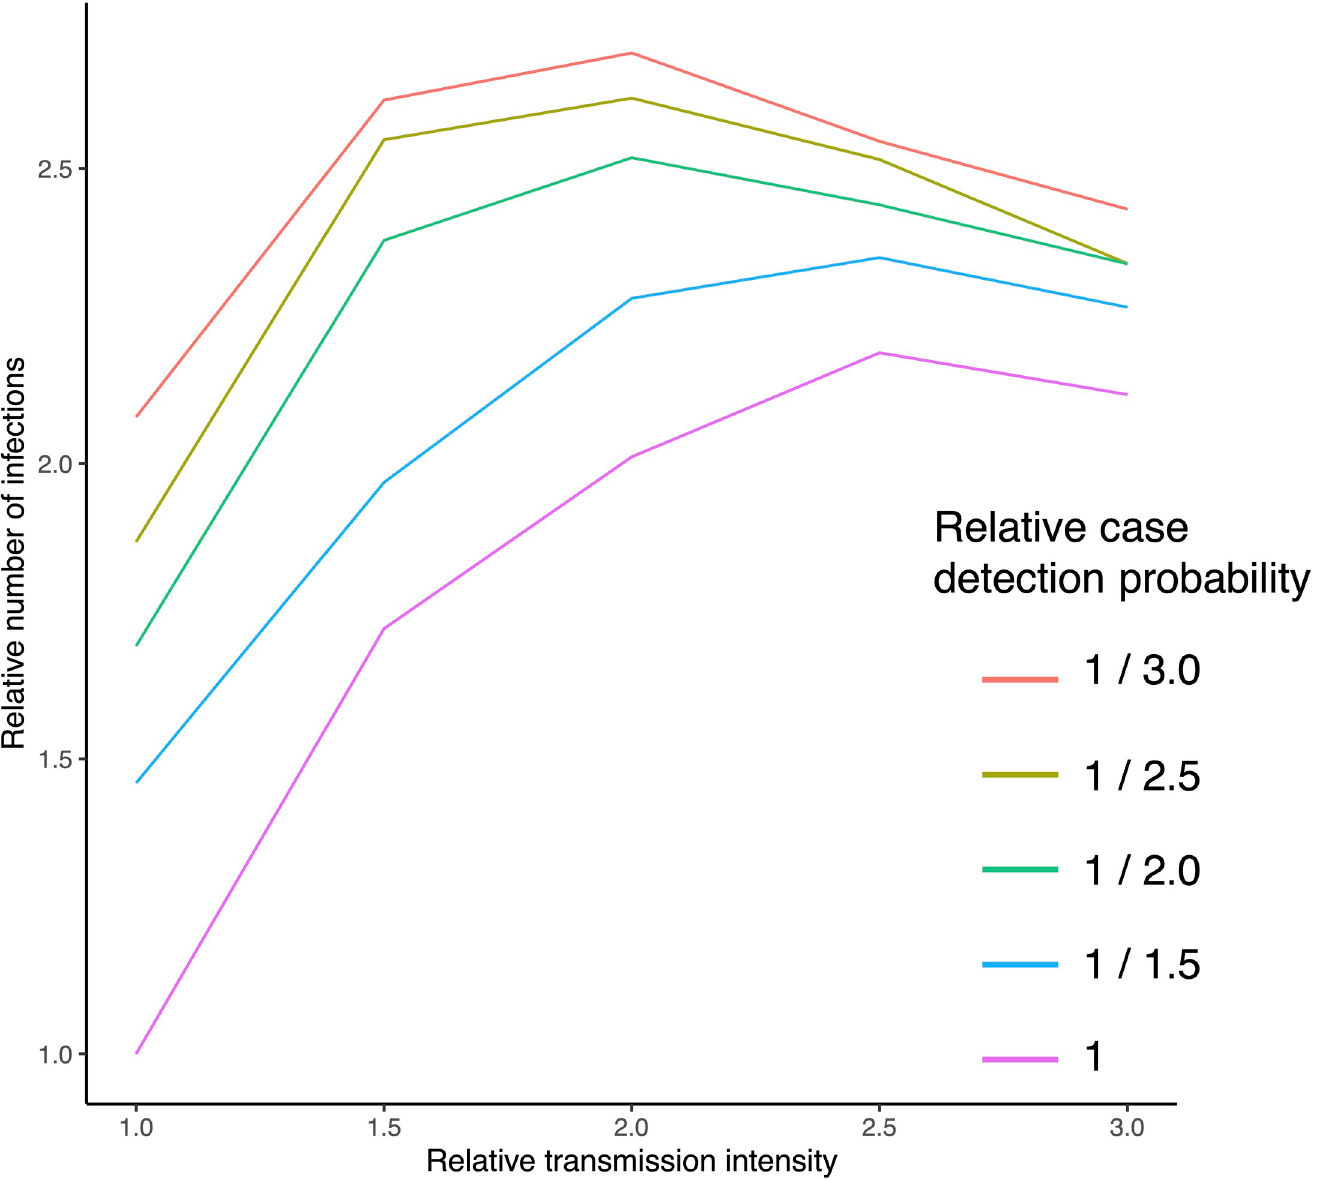
Fig 8. Effectiveness of CATI strategies in higher endemicity settings. All values proportional to Singapore parameters ( β μ and δ ). Assumes drug CATI strategy with 1km radius delivered the day of detection with 81% effective coverage lasting 30 days per response over a 1-year time horizon.